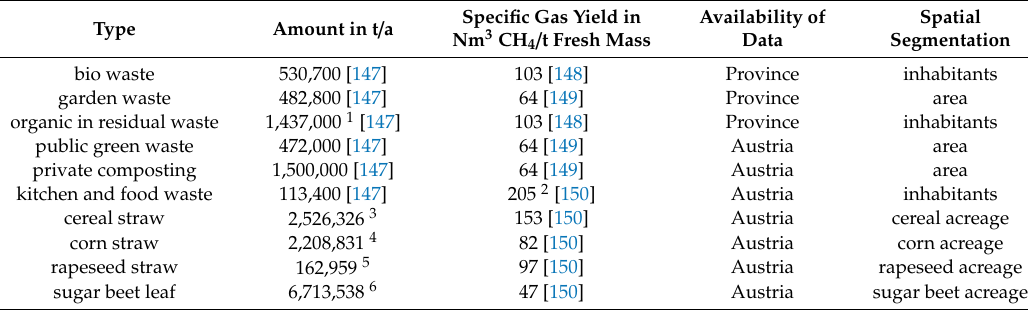
Table 7. Considered types of biogenic